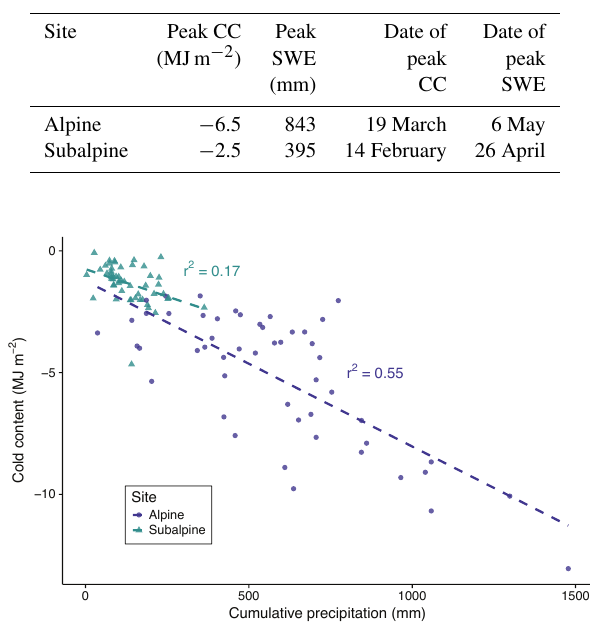
Figure 3. Cold content plotted against cumulative precipitation from 1 December to the date of snow pit observation for the alpine and subalpine for the snow season up to and including the date of peak cold content from WY2007 to WY2013. The dashed lines of best fit were calculated using ordinary least squares linear regres-